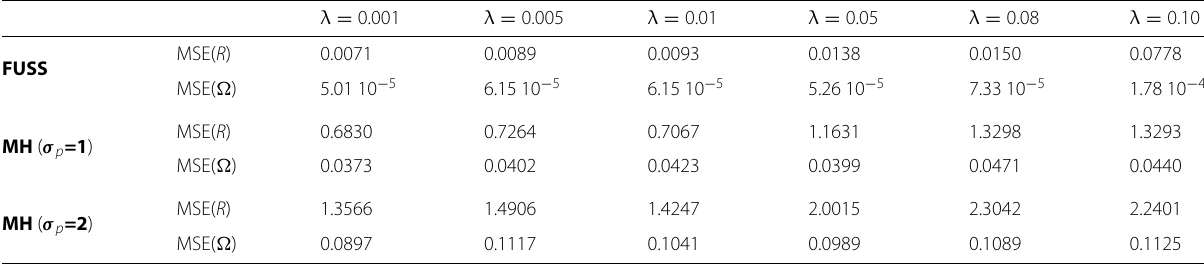
Table 9 MSEs in estimation of R and (cid:22) using FUSS and MH inside a Gibbs sampler, with δ = 10 − 3 , K = 10, and N G = 50, for the example of Section 6.3 λ = 0.001 λ =